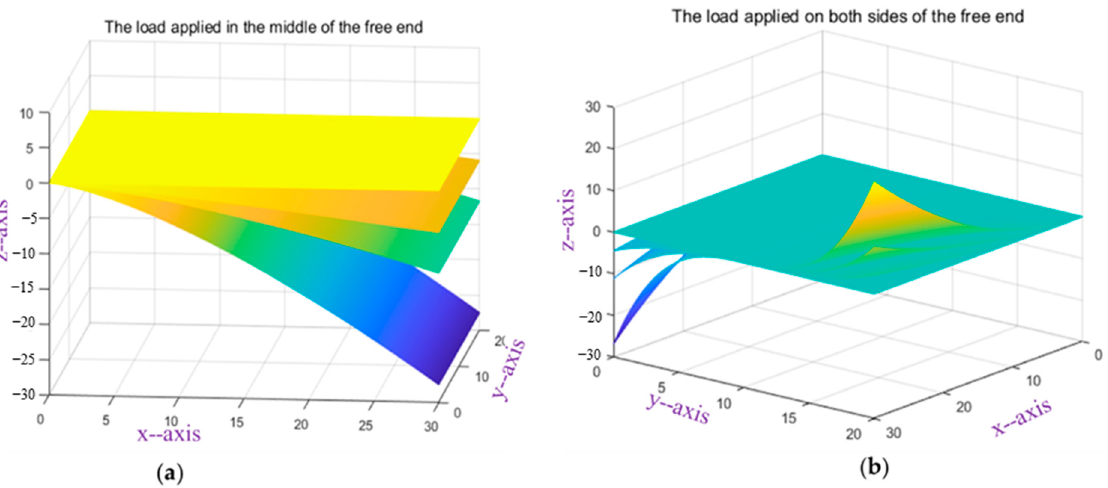
Figure 11. Shape Reconfiguration Chart of the structural specimen: ( a ) Hanging mass block at middle loading point; ( b ) different loads on both sides loading points.